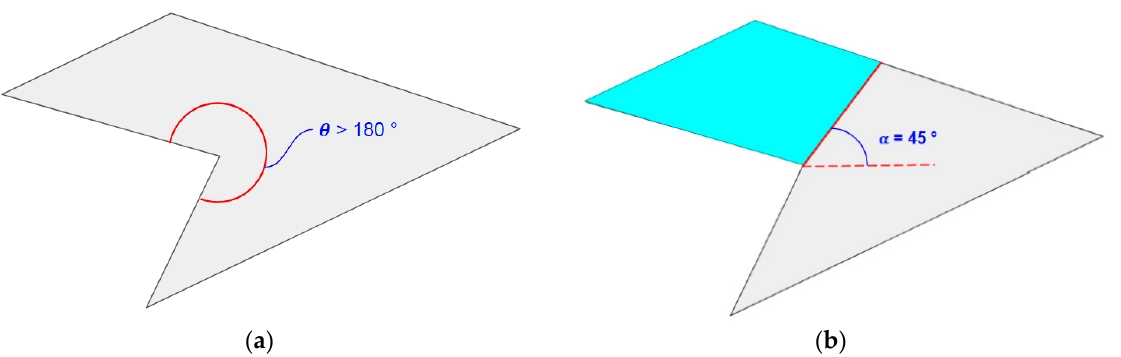
Figure 1. ( a ) Subfield with a vertex that has an internal angle of more than 180 degrees; ( b ) The splitting angle (45 degrees).